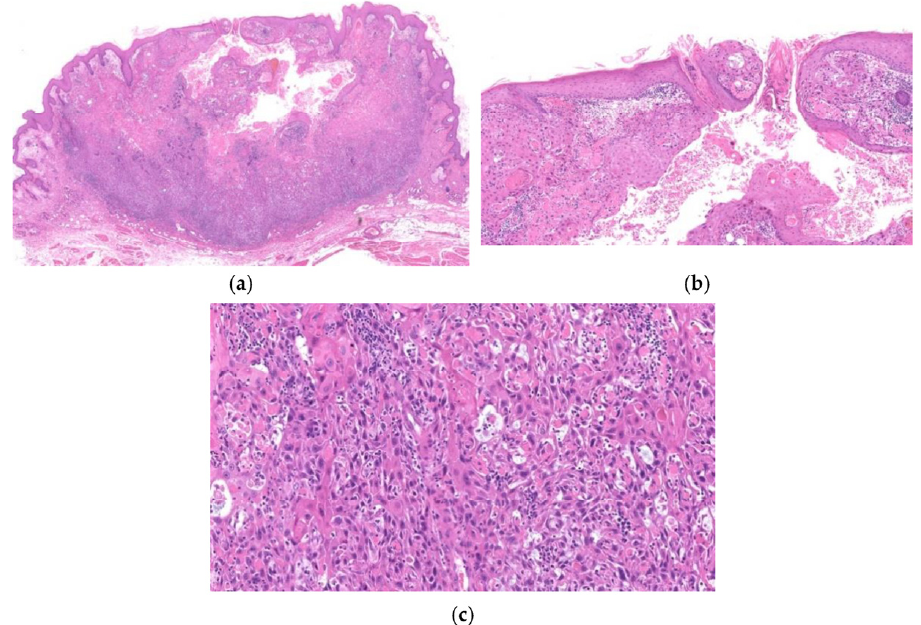
Figure 12. Histopathological findings of crater form of infundibular SCC. The lesion has a crateriform KA-like configuration with a central low keratin-filled ulcer ( a ). The tumor shows neoplastic aggre- gates of SCC expanding from a follicular infundibulum ( b ) and neoplastic cells invade deeply into the dermis ( a , c ). The features of KA or features of bowenoid dysplasia (solar keratosis or Bowen’s disease) are absent in the interfollicular epidermis ( a